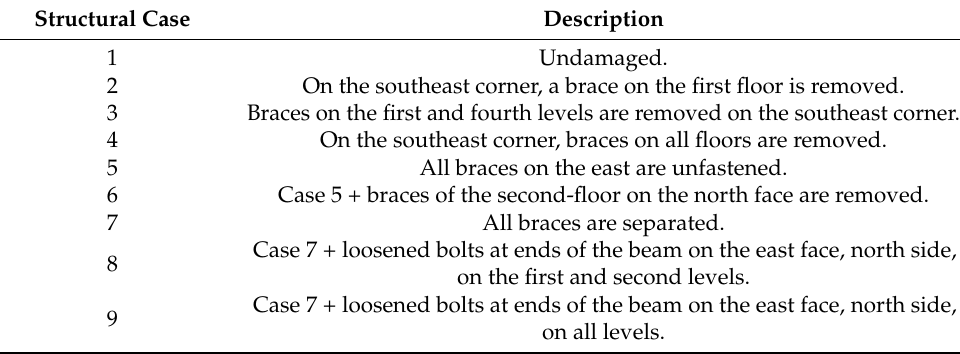
Table 2. Description of the structural cases in the benchmark